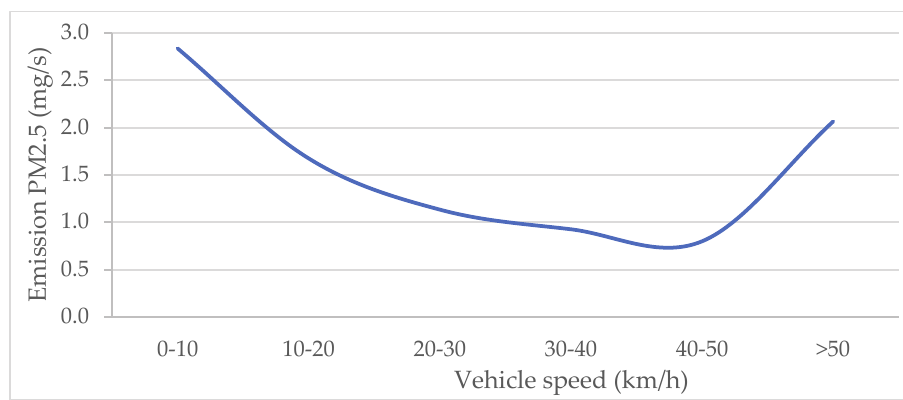
Figure 4. NO X emissions of the different routes.